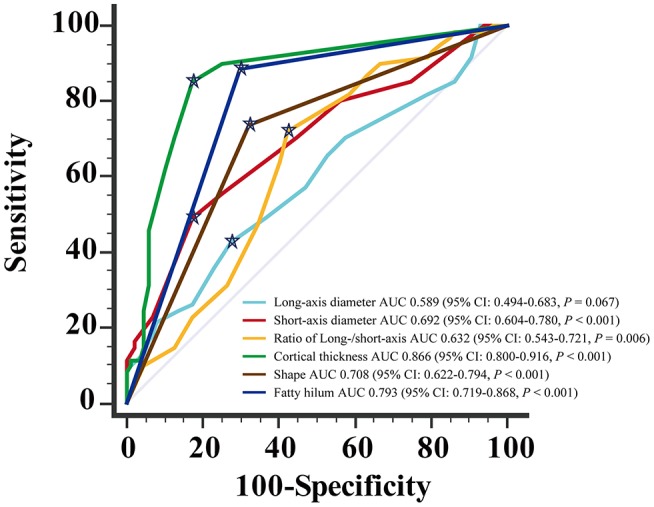
Receiving operating characteristic (ROC) curve analysis for each of MDCT parameter.  Showed the optimal cut-off.